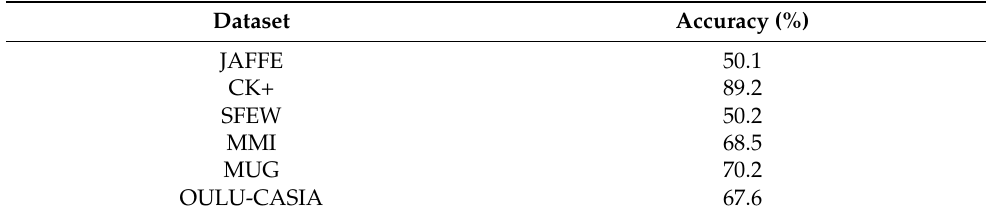
Table 11. Accuracy obtained using cross-database experiments.